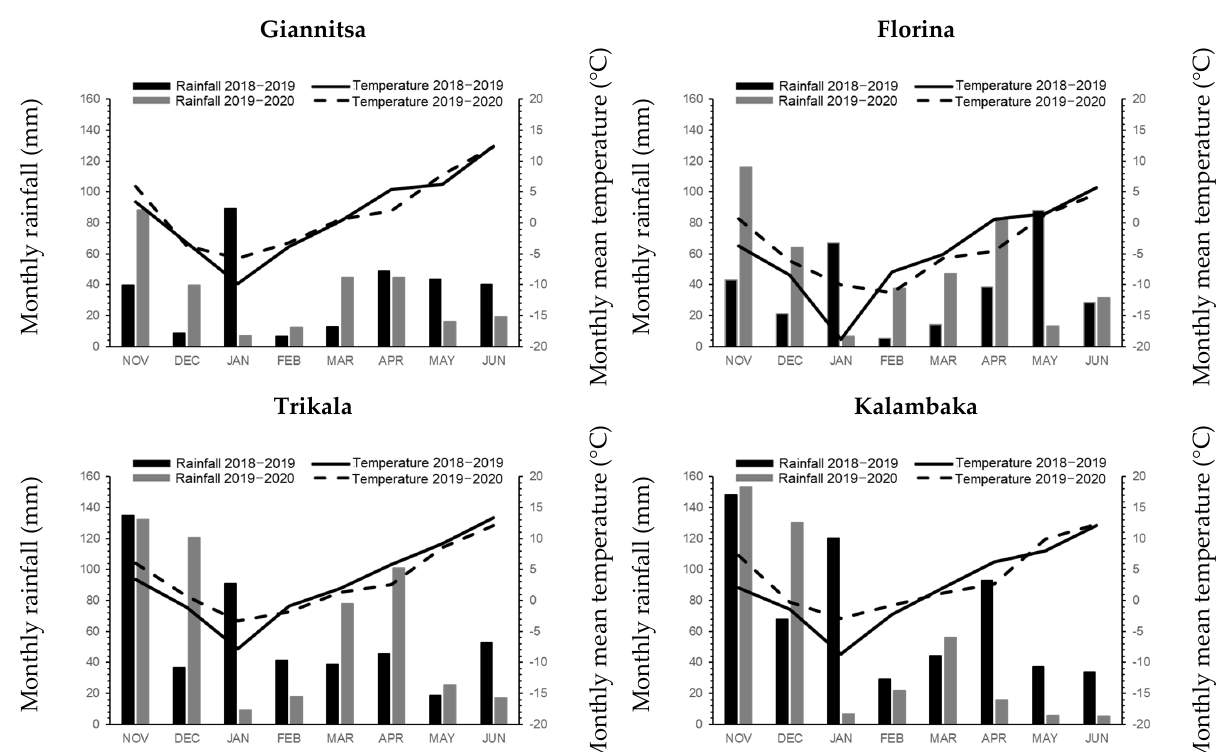
Figure 2. Basic weather data (mean monthly temperature in °C and rainfall in mm) based on daily records, through two growing seasons (years 2018–2019 and 2019–2020) for comparison reasons.